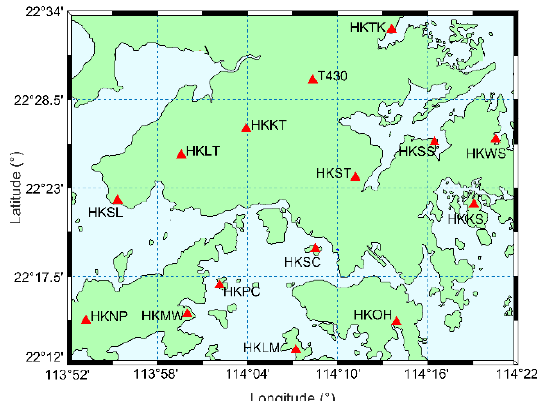
Figure 2. The Continuously Operating Reference Stations in Hong Kong.